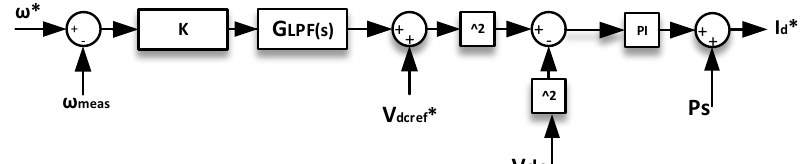
Figure 4. Virtual Inertia Loop based on